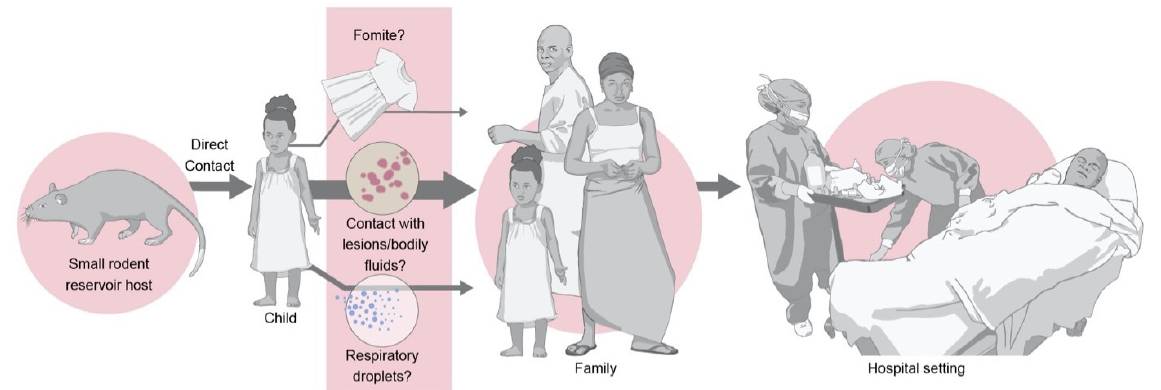
Figure 2. Posited routes of MPXV spillover and human-to-human transmission in endemic areas. The arrow thickness indicates the transmission likelihood.